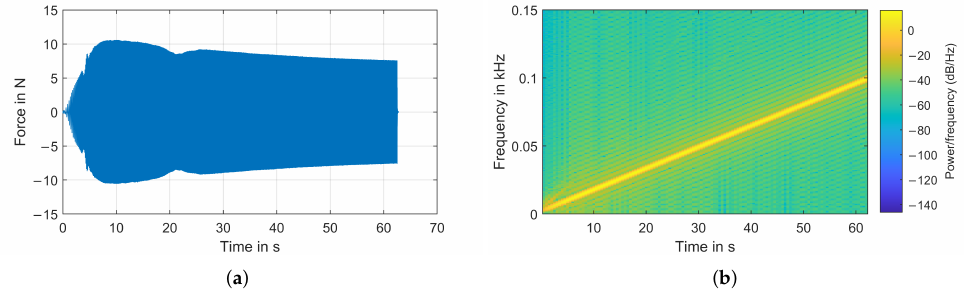
Figure 14. Impulse excitation force no.1.